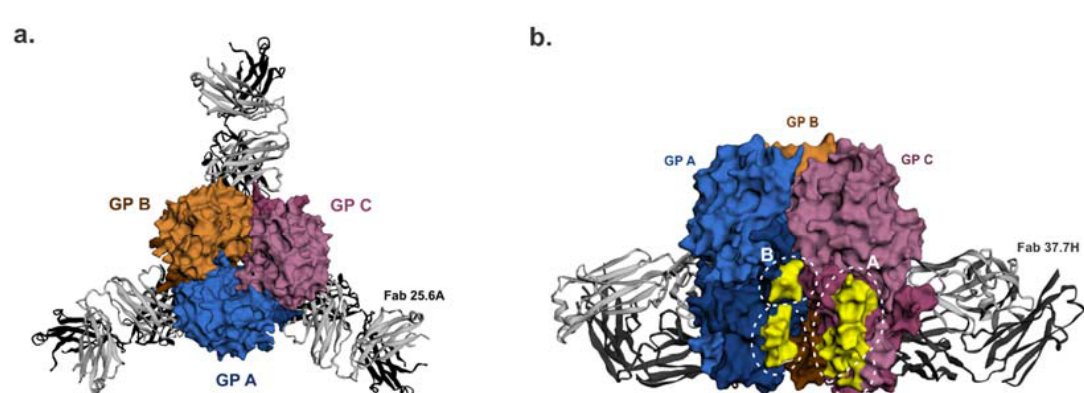
Figure 3. GPC-B † quaternary structure epitope. The 25.6A and 37.7H monoclonal antibodies (mAbs) were raised to the LASV GPC-B conformational epitope. ( a ). (Top view) The LASV GP trimer is bound by three 25.6A Fabs, with each Fab binding two GP monomers near the trimer’s base. ( b ). (Front view rotated 60 ◦ ) The GP trimer bound near its base by three 37.7H Fabs (two Fab in view) in a similar manner as above. Amino acid residues in the 37.7H epitope sites A and B highlighted in yellow to show the antibody footprint. GP monomers are shown as surface representations. LASV GP-mAb bound structures were retrieved from the Protein Database using PDB IDs 6P95 and 5VK2 for 25.6A mAb-bound GP and 37.7H mAb-bound GP respectively, image generated in EzMol 2.1 online program [60] and labelled manually.